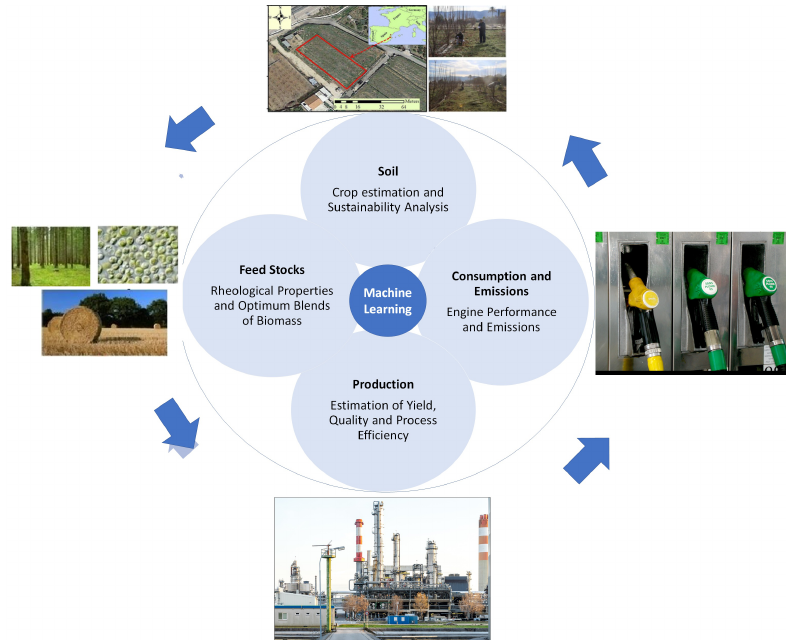
Figure 1. Machine Learning applications in the life cycle of biofuels.